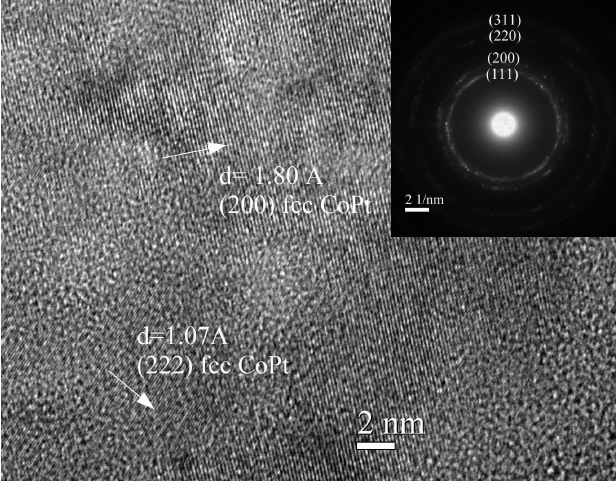
Figure 4. An area of the as-cast Co 48 Pt 28 Ag 6 B 18 sample showing (200) and (222) planes of fcc CoPt phase; Inset: the SAED